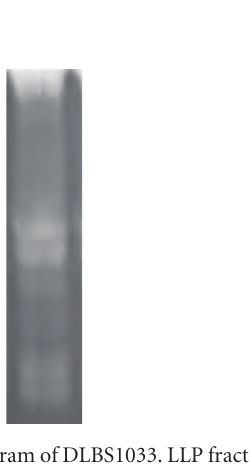
Figure 3: Lumbricus low-molecular-weight protein profile of DLBS1033. The eathworm extract has 8 major proteins with molecular weight below 100 kDa.